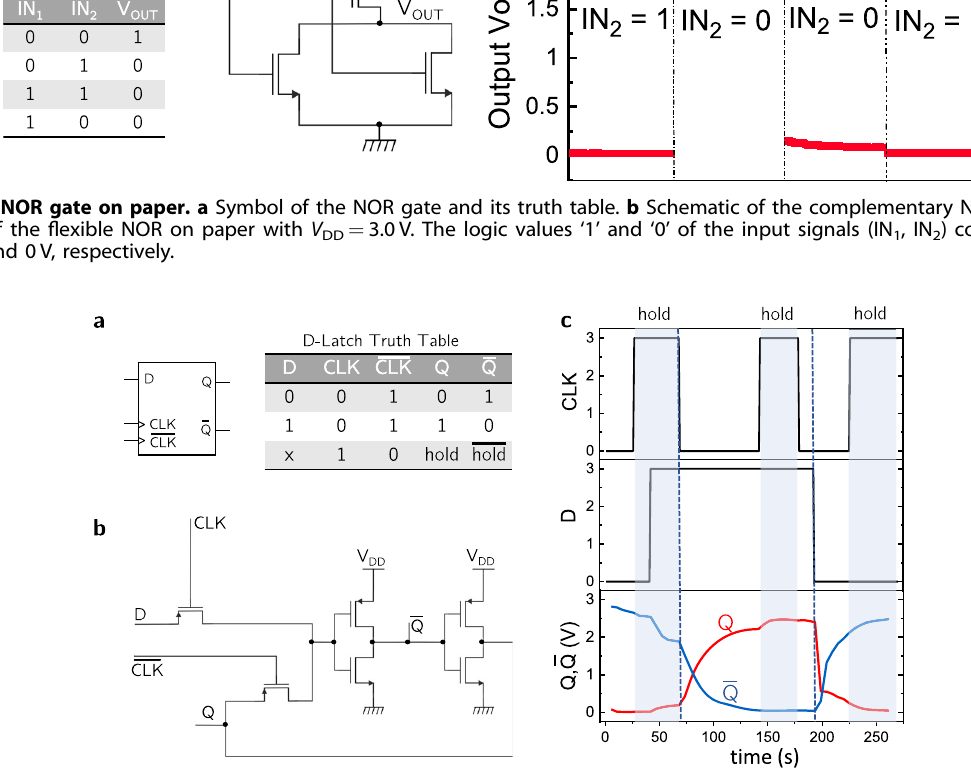
Fig. 4 Flexible hybrid complementary-PTL D-Latch on paper. a Symbol of the complementary-PTL D-Latch, and its truth table. b Schematic of the complementary-PTL D-Latch. c Time evolution of the output, Q , and the inverse output, Q , as a function of the input signal, D , and clock, CLK. The blue zones show the hold phases of the Latch, while the dash-dot lines highlight the output voltage